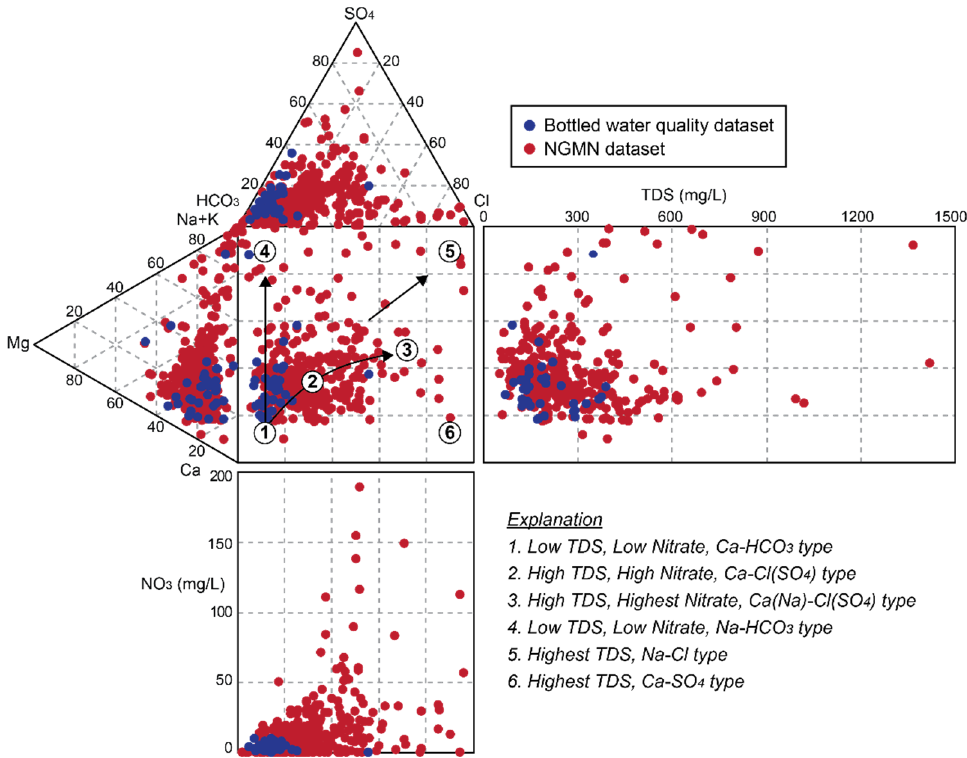
Figure 7. Durov diagram comparing the hydrochemical types of South Korean bottled water samples ( n = 37) of groundwater ( n = 299) from South Korean National Groundwater Monitoring Network (NGMN) (modified after [110]).